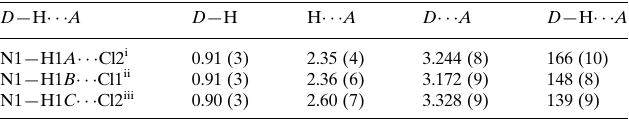
Hydrogen-bond geometry (A˚ , (cid:5)